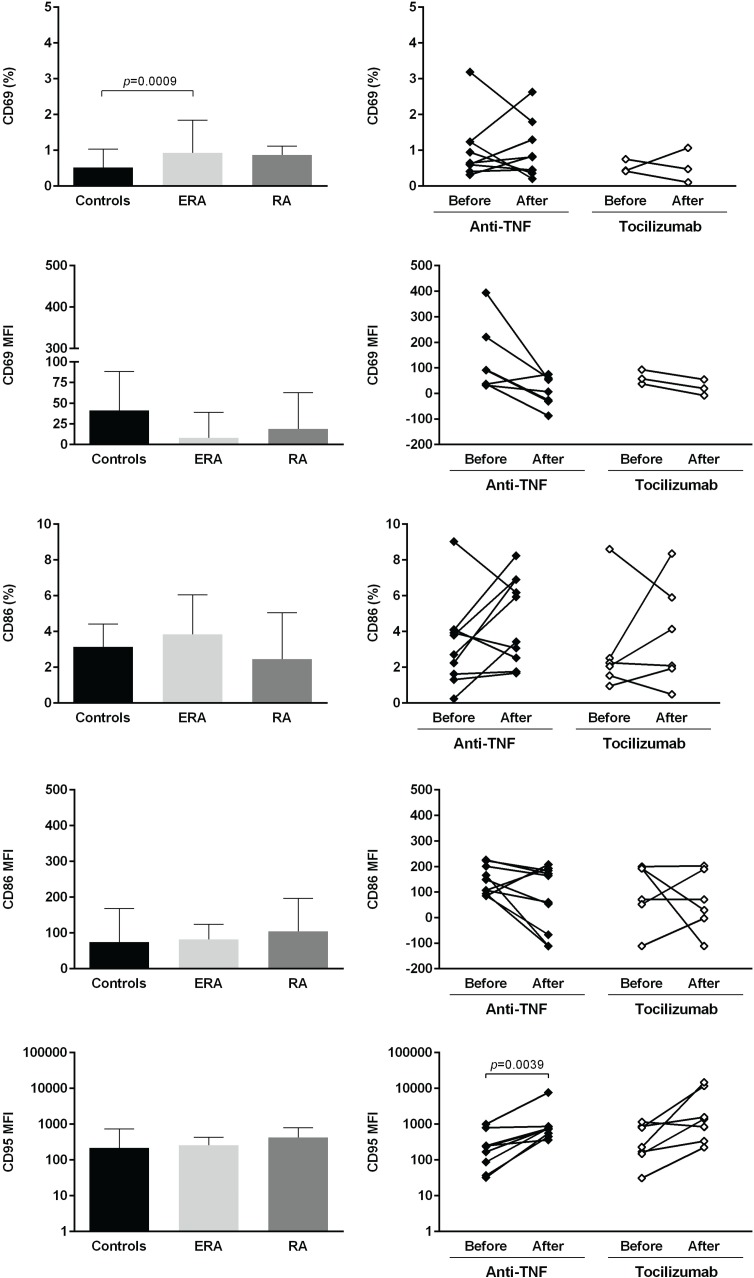
CD95, but not CD69 or CD86 B-cell expression increase after treatment with TNF-inhibitors and tocilizumab in rheumatoid arthritis.The expression of activation (CD69, CD86) and apoptosis (CD95) cell markers was analyzed on B-cells (frequency and median fluorescence intensity, MFI) to characterize B-cell phenotype in circulation in early RA (ERA) and established RA patients under methotrexate treatment. The effect of TNF-inhibitors and tocilizumab treatment on B-cell markers expression was also assessed in established RA patients at baseline and after an average of 8 months of treatment. Bars represent median values with interquartile range. Differences were considered statistically significant for p<0.05. Non-parametric Mann-Whitney test was used for comparisons between 2 independent groups. For paired samples (before and after treatment), the Wilcoxon signed-rank test was used.